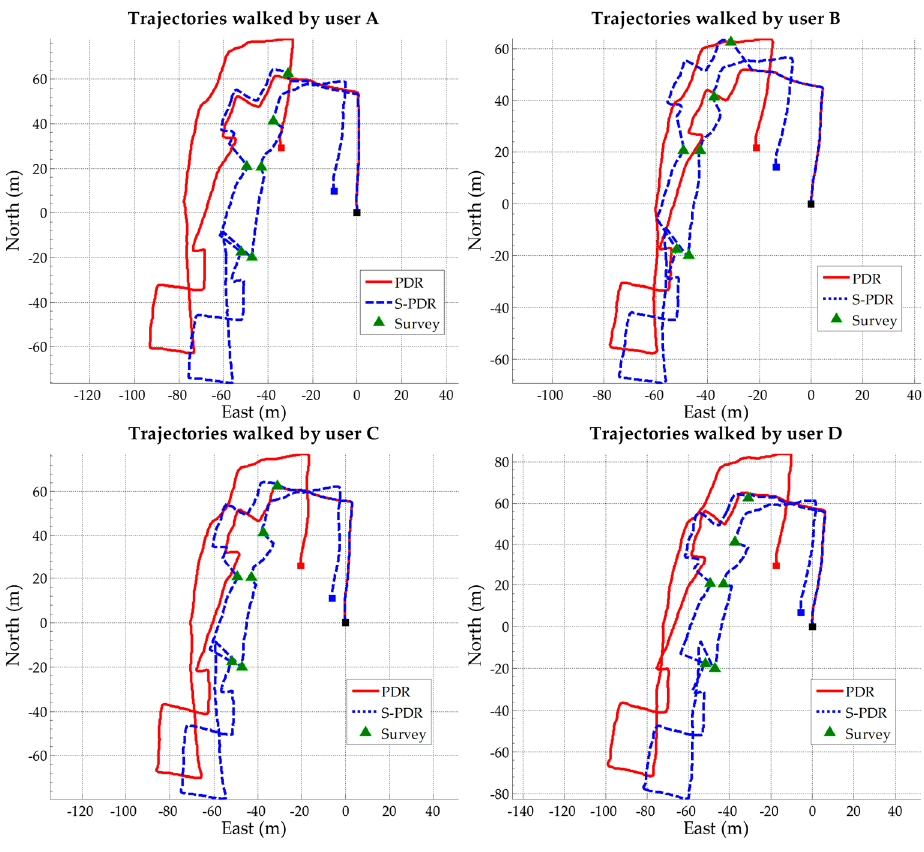
Figure 14. The trajectories of four participants using an iPhone.